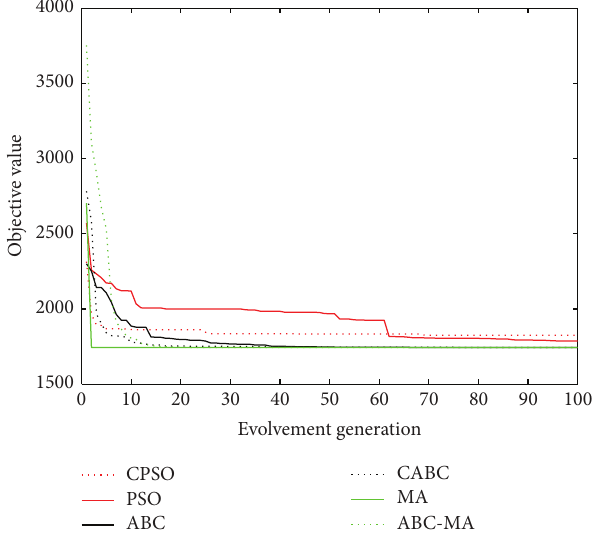
Figure 8: The convergence curve of the Iris data.